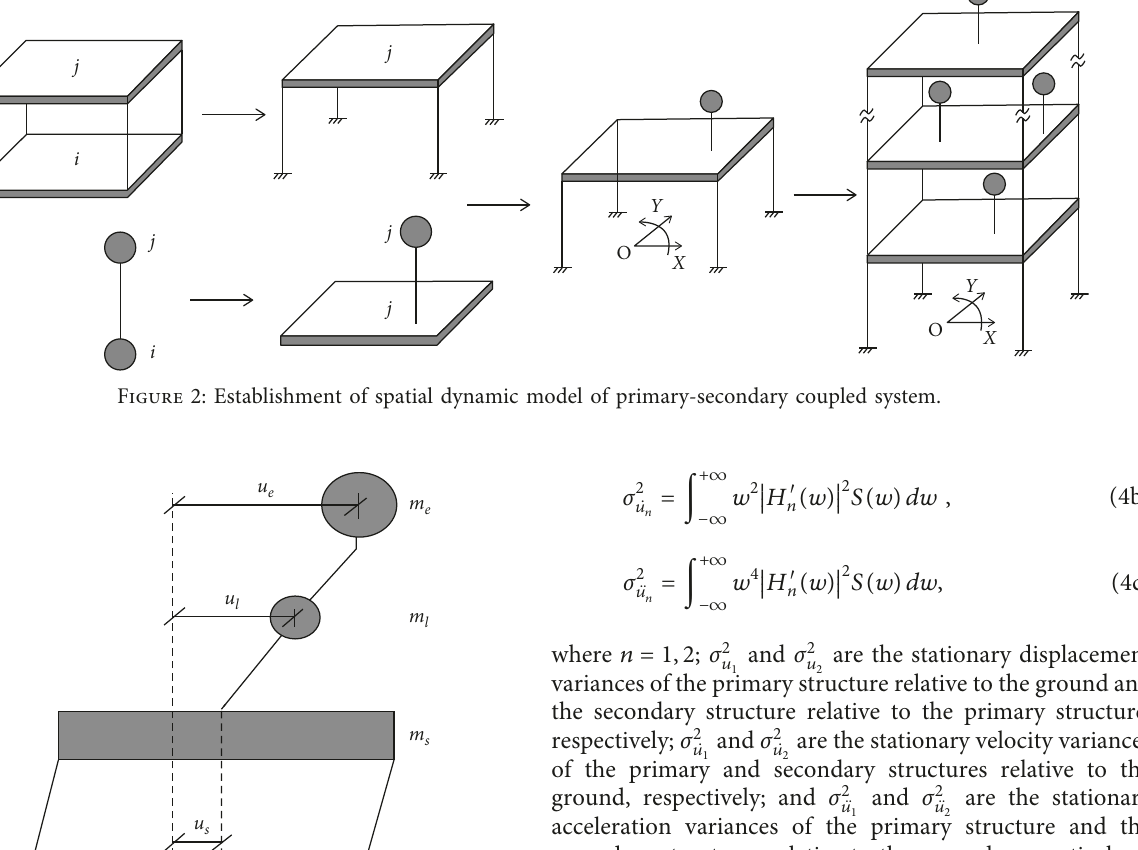
Figure 3: Three-DOF series